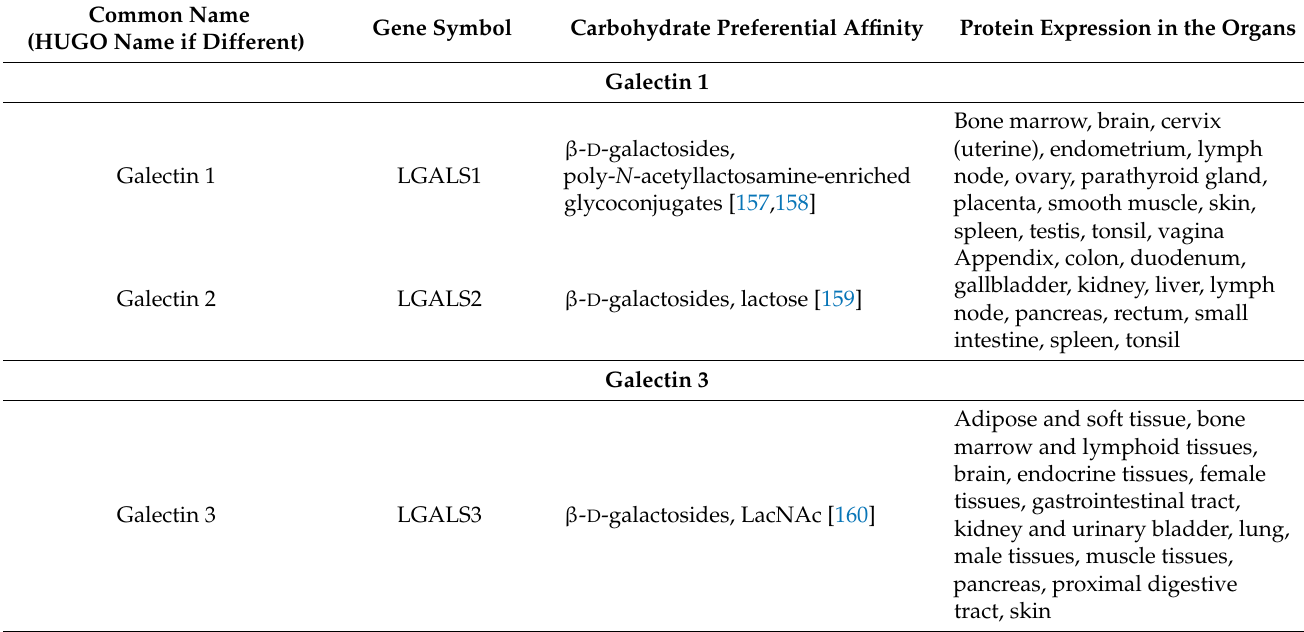
Table 11. Human S-type lectins, their carbohydrate ligands and protein epression in the